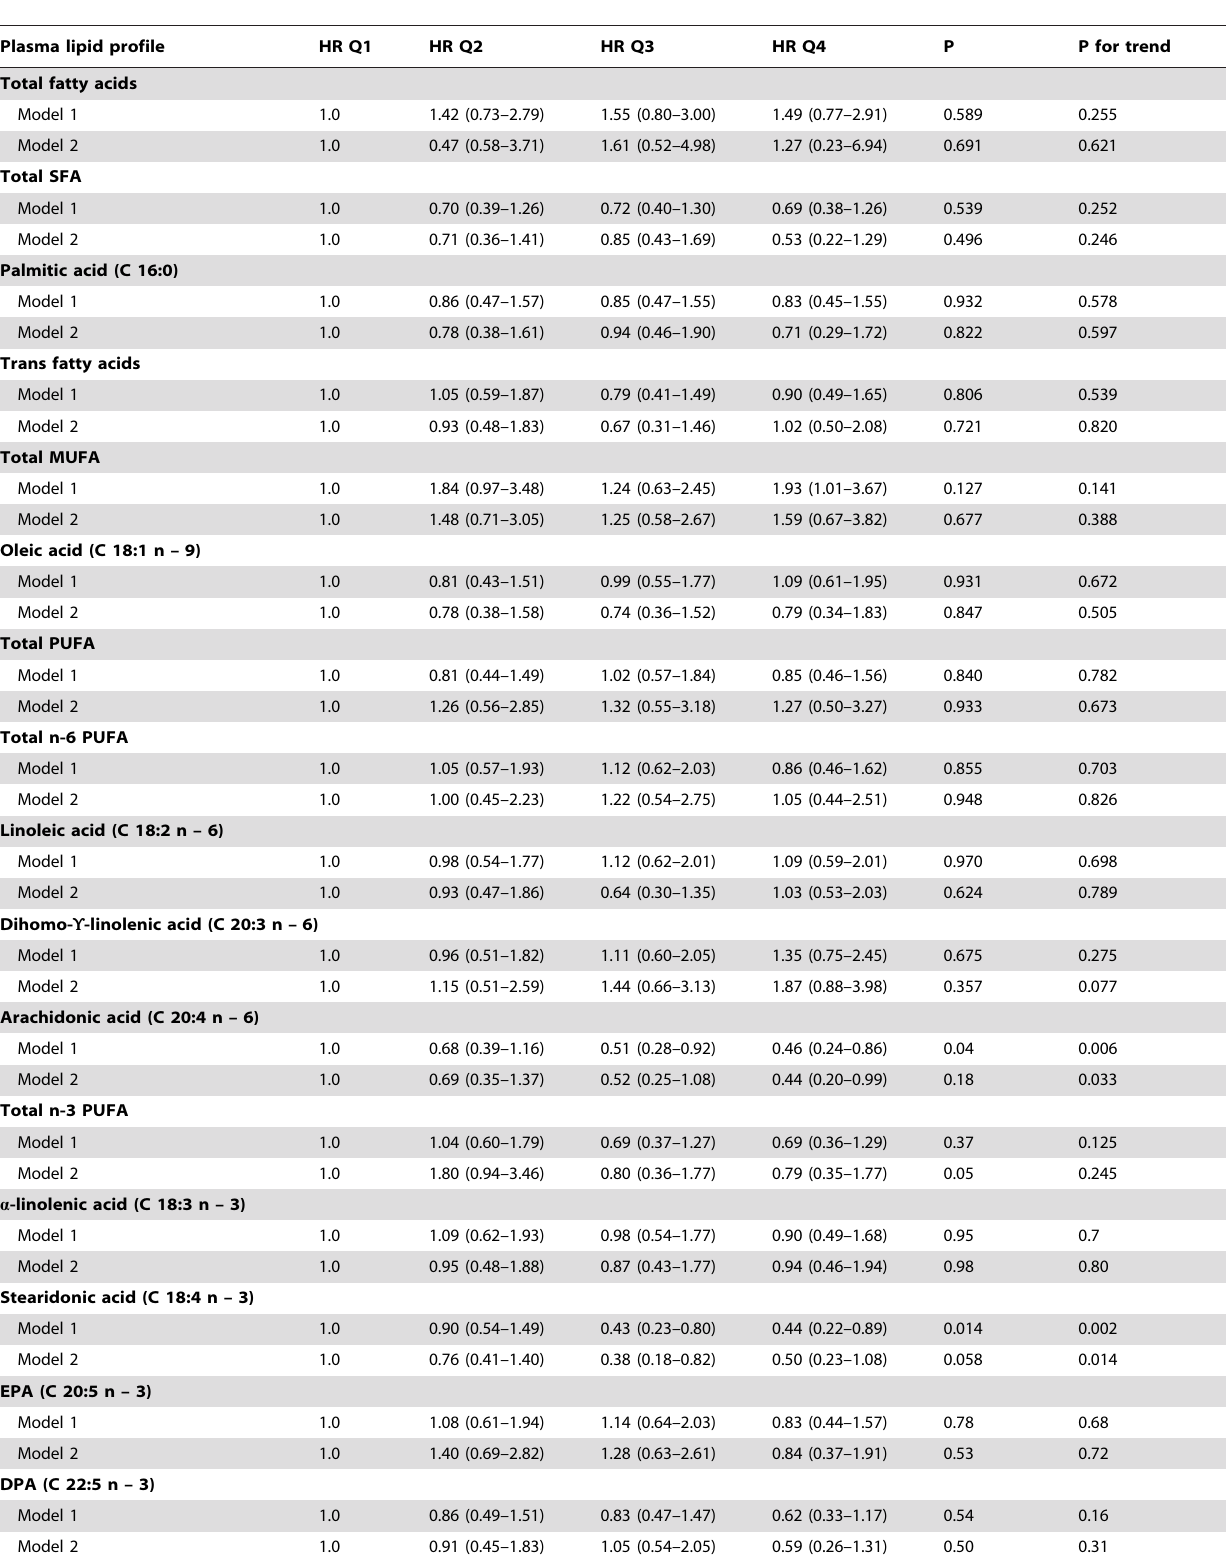
Table 5. Multivariate hazard ratios (95% confidence intervals) showing the associations between baseline plasma lipid profile and incident cerebrovascular events in the SU.FOL.OM3 study.